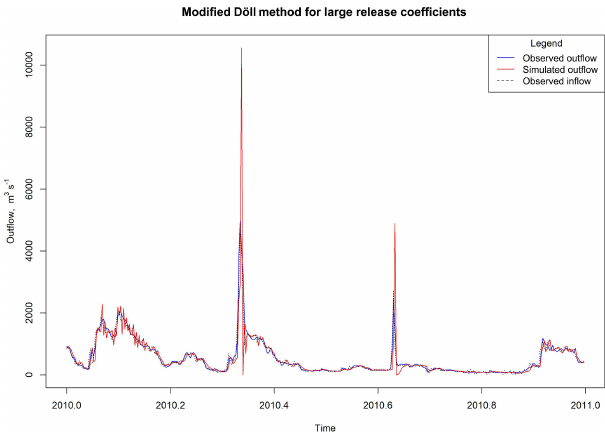
Figure 11. Outflow simulation for the Old Hickory Dam using the proposed modification of the Döll method for k rd = 0 .